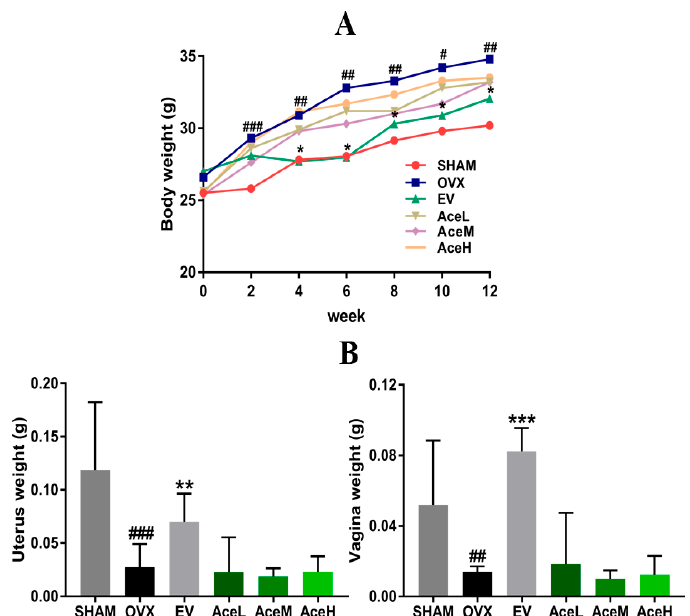
Figure 1. Effects of acteoside on body, uterine, and vaginal weights after being ovariectomized. ( A ) Body weight changes of all mice after surgery from 0 week to 12 weeks. ( B ) Effects of OVX (no treatment) and drug treatment on uterus and vagina wet weights of mice ( n = 10); values were presented as the mean ±standard deviation (SD); ** p < 0.05, *** p < 0.001 relative to the mice of OVX model group; # p < 0.05, ## p < 0.01, ### p < 0.001 relative to the SHAM mice.